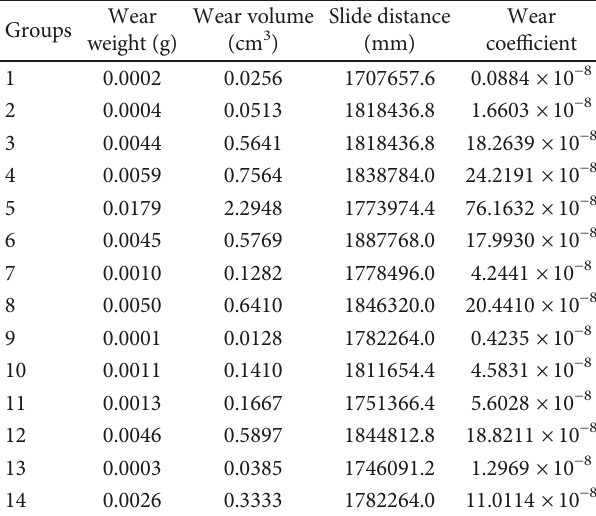
Table 5: Wear coe ffi cient.